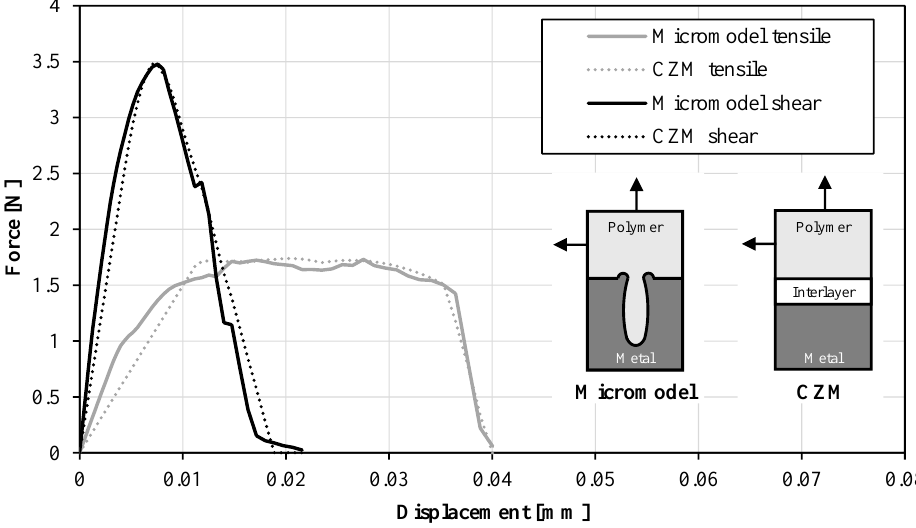
Figure 12. Comparison of force – displacement curves for the micromodel and the cohesive-zone model.